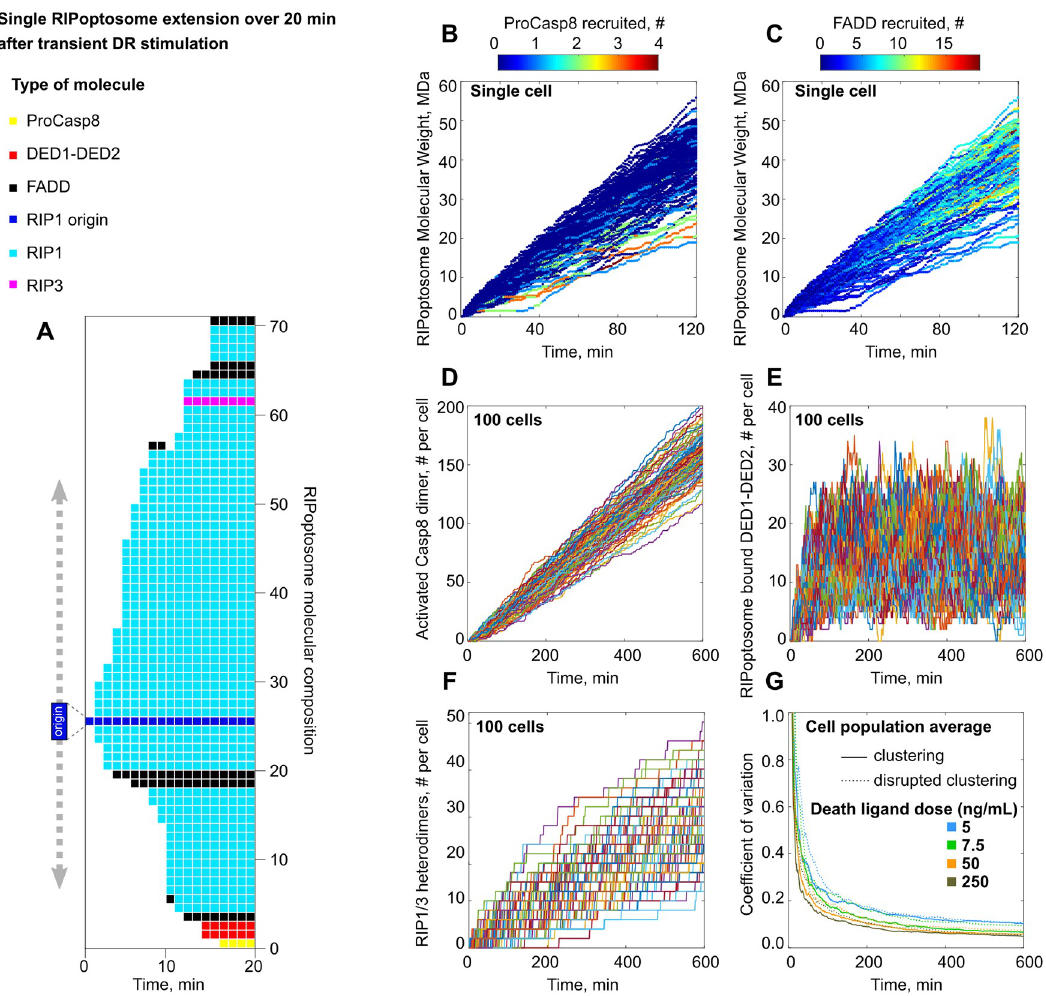
Fig 3. Simulated by model stochastic molecular assembly of RIPoptosome and Casp8, RIP1/RIP3 activation in a single cell. (A) Model generated individual RIPoptosome growth over first 20 min after DR stimulation with 5ng/mL of DL assuming receptor clustering scenario. (B,C) RIP1 filaments formation triggered immediately after DR stimulation which results in RIPoptosomes of size 2 MDa and higher within first 5 min. (B) ProCasp8 recruitment is mostly abundant in the filaments of the lower molecular weight. (C) FADD recruitment is proportional to the filament molecular weight and persistently increases with the filament progression. (D) Single cell stochastic traces of RIPoptosome driven Casp8 activation, (E) accumulation of DEDs (DED1-DED2) and (F) RIP1-RIP3 heterodimers induced by treatment with 5 ng/mL of the DL. 100 traces shown generated assuming DR clustering scenario. (G) Time dependant variability in Casp8 activation over population of 100 cells stimulated with DL doses of 5, 7.5, 50 and 250 ng/mL for regular (solid line) and disrupted (dashed line) receptor clustering